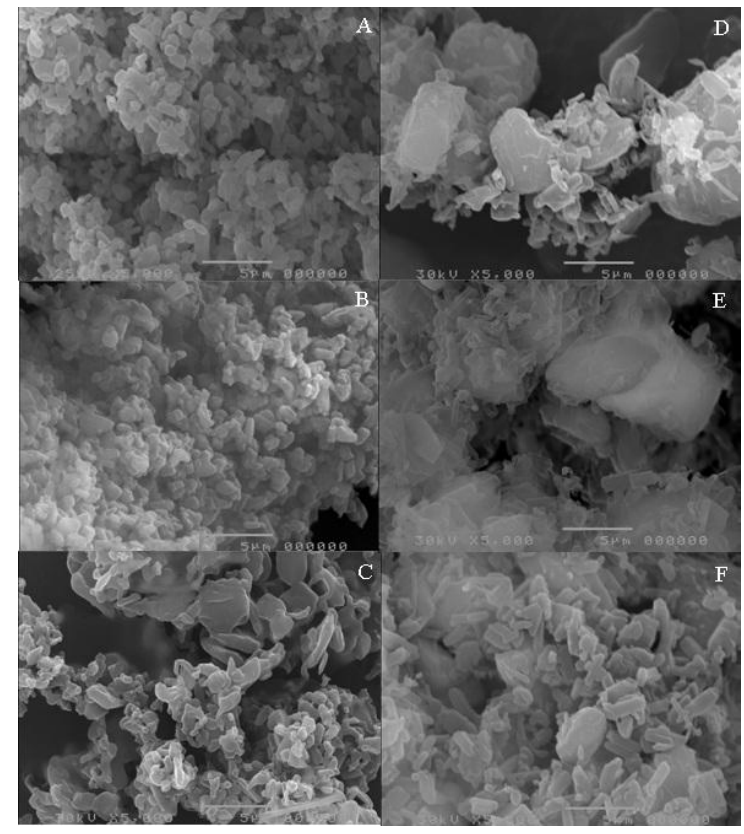
Figure 3. Photomicrographs of co-micronized mixtures EFV:SLS ( A ) (1:0.25); ( B ) (1:0.50) and ( C ) (1:1) and ( D ) EFV:PVP (1:0.25); ( E ) (1:0.50) and ( F ) (1:1).